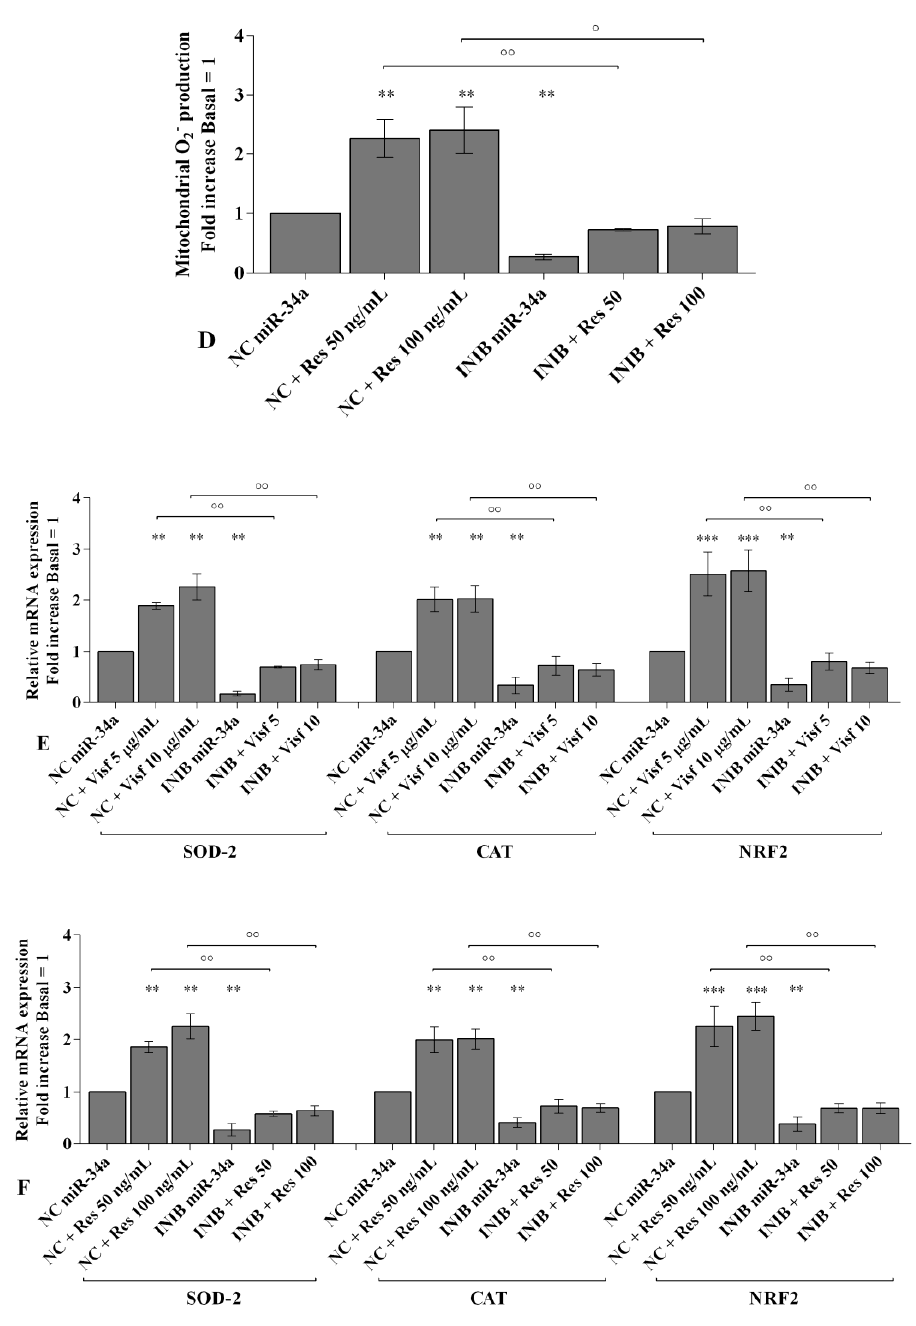
Figure 6. ( A , C , D ) Mitochondrial superoxide anion production was assessed by the analysis at flow cytometry using MitoSox Red staining. ( B , E , F ) Expression levels of superoxide dismutase ( SOD-2 ), catalase ( CAT ), nuclear factor erythroid 2 like 2 ( NRF2 ) by real-time PCR. Human osteoarthritic (OA) synovial fibroblasts were evaluated at basal condition, after 24 h of transfection with miR-34a inhibitor or NC, and after incubation with visfatin (5 and 10 μg/mL) and resistin (50 and 100 ng/mL). The superoxide anion production and the gene expression were referenced to the ratio of the value of interest and the value of basal condition (basal, cells without treatment) or NC, reported equal to 1. Data were expressed as mean ± SD of triplicate values. ** p < 0.01, *** p < 0.001 versus basal condition or NC. ° p < 0.05, °° p < 0.01 versus inhibitor. INIB= inhibitor, NC= negative control siRNA, Visf= visfatin, Res = resistin.